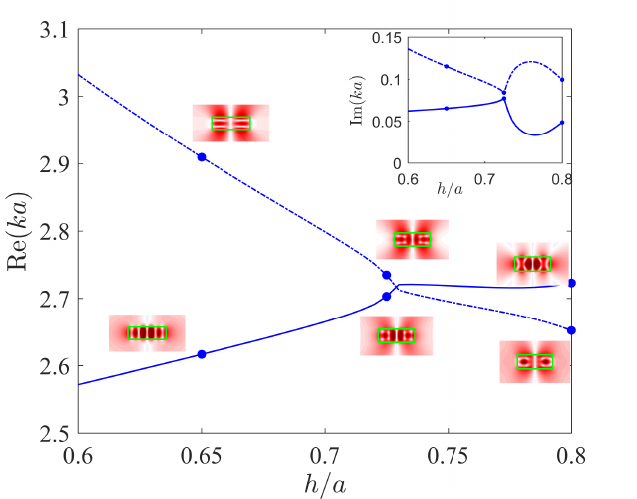
Figure 1. Evolution of complex TE resonant frequencies in single dielectric disk with the permittivity (cid:101) = 12 in the sector m = 0 for variation of aspect ratio h / a where a is the radius and h is the thickness of the disk. The insets show the azimuthal component | E φ | of the electric